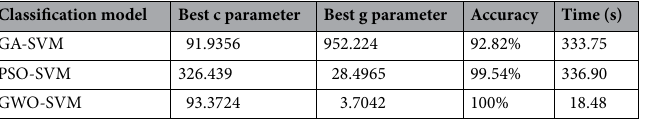
Table 4. Comparison table of results obtained by three optimization algorithms for Sallen–Key bandpass filter.